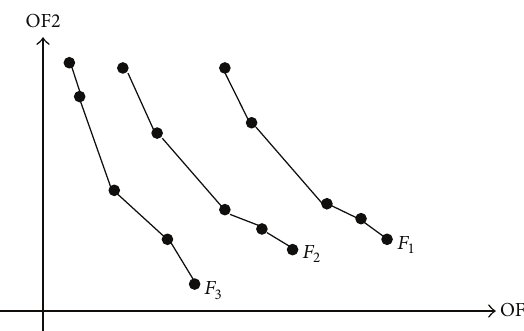
Figure 3: Illustration of a front set 𝐹 , where 𝐹 = {𝐹 1 , 𝐹 2 ,𝐹 3 } . Each point represents one feasible solution in one front in the 2- dimensional space. 𝐹 1 (resp., 𝐹 3 ) is best (resp., worst) front, and the solutions in 𝐹 1 , 𝐹 2 , and 𝐹 3 have the nondomination rank of 1, 2, and 3,